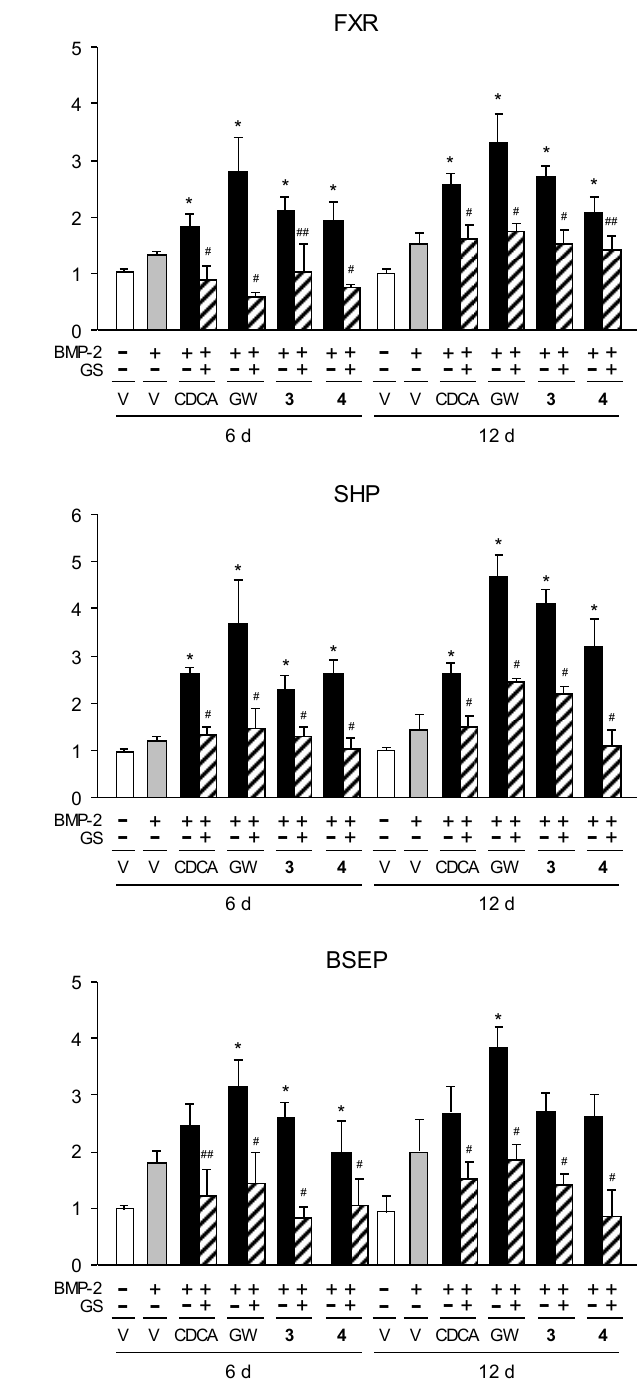
Figure 4. Expression of FXR and its target genes during osteoblast di ff erentiation of ST-2 MSCs. The ST-2 MSCs (vehicle: V; white columns) were di ff erentiated into osteoblasts for 6 or 12 days in the medium containing BMP-2 (50 ng / mL; gray columns) in the presence or absence of one of the FXR agonists, 10 µ M CDCA, 5 µ M GW4064 (GW), and 5 µ M of novel synthesized FXR agonist 3 or 4 (black columns), and / or 25 µ M GS (hatched columns). The expression levels were measured by quantitative PCR (qPCR). Data are presented as means ± S.D. from three experiments. * p < 0.01, as compared with the BMP-2-treated cells, # p < 0.01, ## p < 0.05, as compared with the FXR agonist-treated cells.